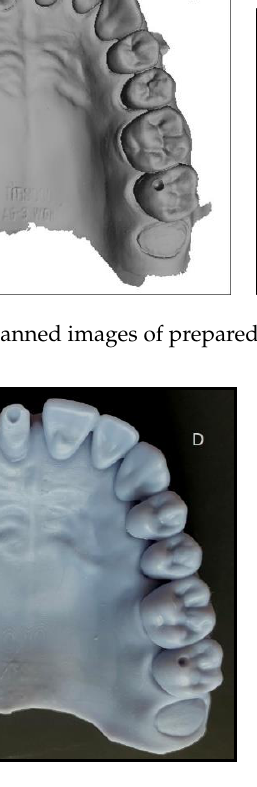
Figure 4. Cast fabricated using digital impression technique and 3D printing.